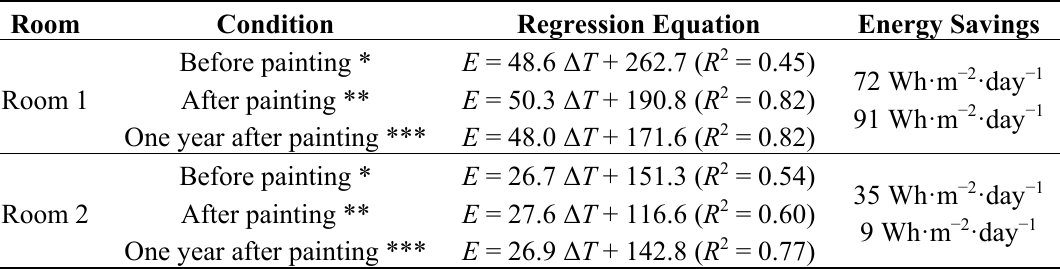
Table 2. Regression equations for cooling power consumption due to air temperature difference between outdoor and room condition for the scenarios (1) before, (2) immediately after, and (3) one year after painting, in rooms 1 and